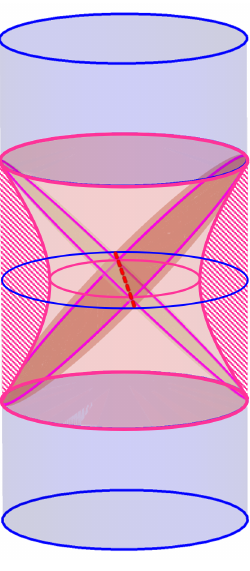
Figure 1 . Bulk AdS 4 with a de Sitter 3 brane. The brane is represented as a (magenta) hyperboloid ( σ = σ b in (3.5)), and gravity is induced on it from integrating out the UV degrees of freedom of the CFT 3 excluded by the brane (dashed magenta region). One performs surgery by gluing two copies of the region σ < σ b along the two-sided brane. The brane is following an accelerating trajectory, and the bulk acceleration horizons give rise to cosmological horizons on the induced dS geometry. The red dashed line is the bifurcation surface of the Rindler-AdS horizons. When the brane is introduced, it becomes a compact surface of finite area